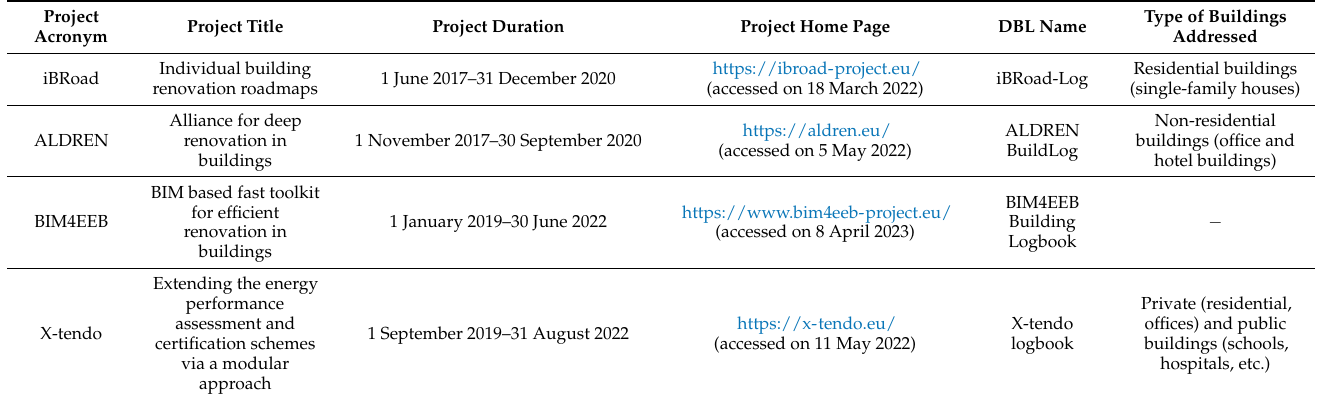
Table 1. List of European projects addressing the structure of a digital building